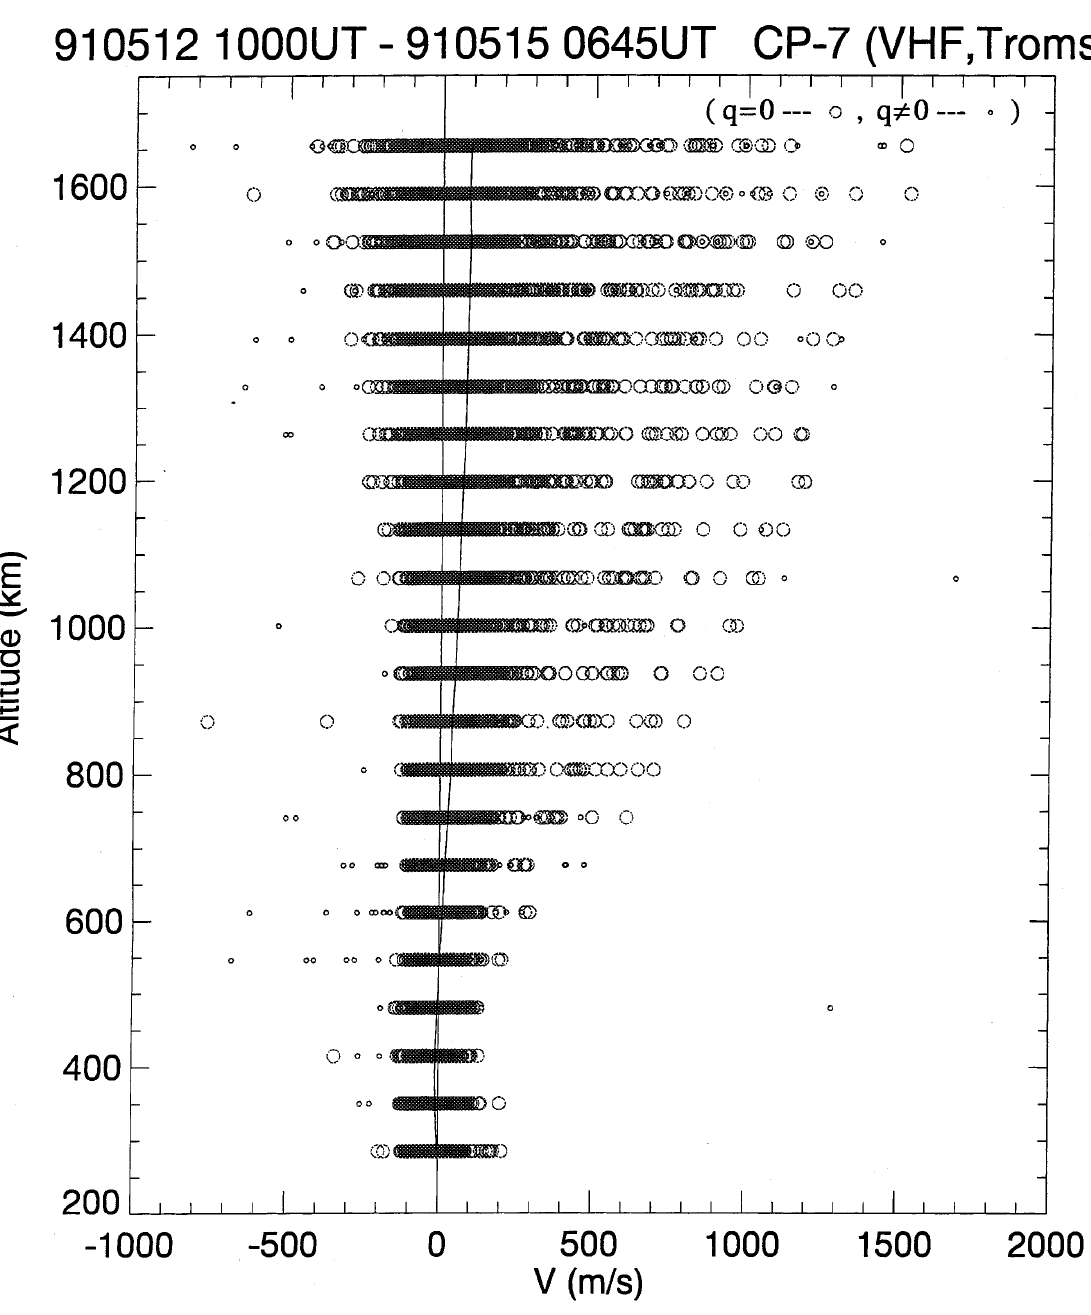
Fig. 2. An over-plotted height profile of the ion velocity for 69 h from 1000 UT on May 12 to 0645 UT on May 15, 1990. The ion velocity for the majority of the data is concentrated in a certain